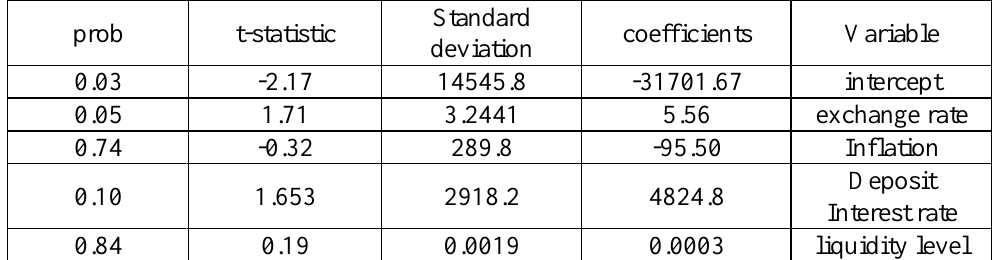
Table 5. Results of Equation One: Stock Price Index as Independent